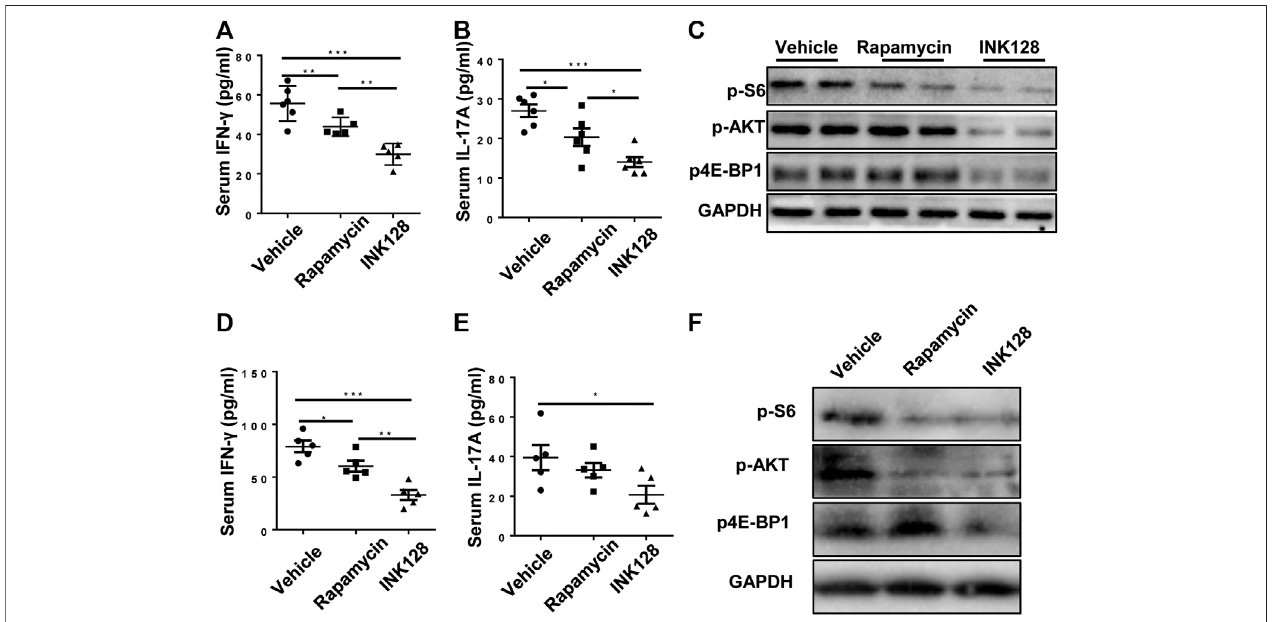
FIGURE4| INK128suppressesmTORC1andmTORC2activityinCD4 + TcellsinMRL/lprmice. (A,B) SerumlevelsofIFN γ andIL-17AweredeterminedbyELISA. Data are representative or are the median ± interquartile range from 5 or 6 independent experiments with one mice per group in each experiment. (C) Immunoblot analysisofphosphorylatedof4EBP1,S6K1andAKTinlysatesofCD4TcellsinMRL/lpr mice. (D,E) CulturesupernatantofIFN γ andIL-17Aweredetermined byELISA. Data are representative or are the median ± interquartile range from 5 or 6 independent experiments with one mice per group in each experiment. (F) Immunoblot analysis of phosphorylated of 4EBP1, S6K1 and AKT in lysates of CD4 T cells. Data are representative or are the median ± interquartile range from 5 or 6 independent experiments with one mice per group in each experiment. Data was analyzed by the non-parametric Mann-Whitney U-test. (* p ≤ 0.05, ** p ≤ 0.01, *** p ≤